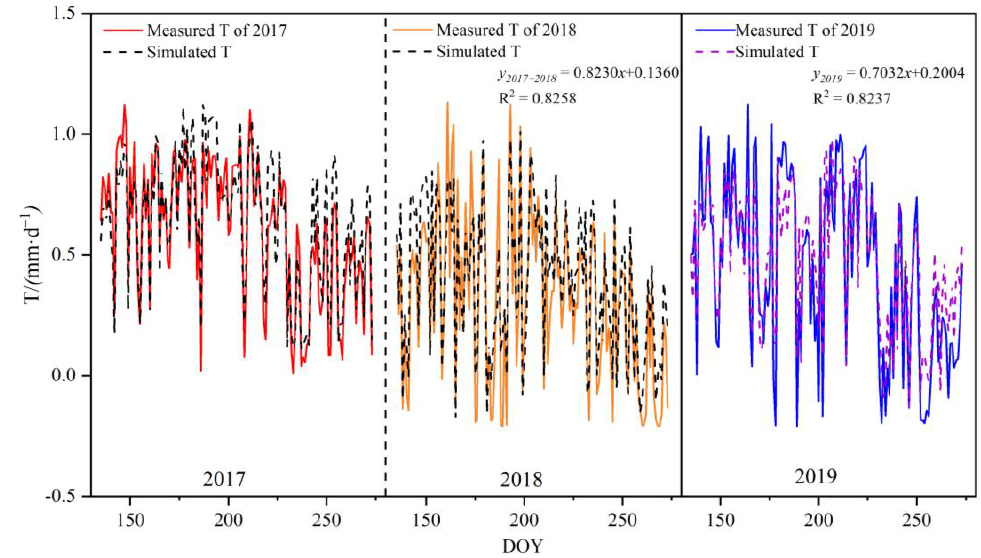
Figure 5. Comparison of the measured and simulated T values during the calibration (2017–2018) and validation (2019) phase.